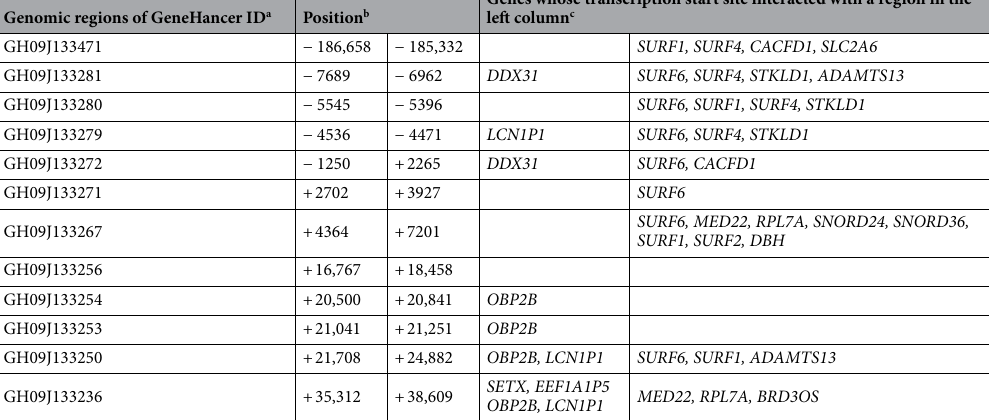
Table 1. Genomic regions interacting with the transcription start sites of ABO . a Genomic regions interacting with the ABO transcription start site are listed on the basis of publicly available data of GeneHancer Regulatory Elements and Gene Interactions 36 . b Positions of interacting regions are denoted relative to the ATG translational start site of ABO, chr 9:136,150,605 in human GRCh37/hg19. c Genes whose transcription start sites are interacted with a region in the left column are shown in the right-hand columns, genes present upstream of ABO on the telomere side are shown on the right, the genes downstream of ABO on the centromere side are shown on the left. OBP2B and LCN1P1 belong to a Lipocalin family, whereas LCN1P1 is a pseudogene. Positions of LCN1P1 , SLC2A6 and EEF1A1P5 are not shown in Fig.